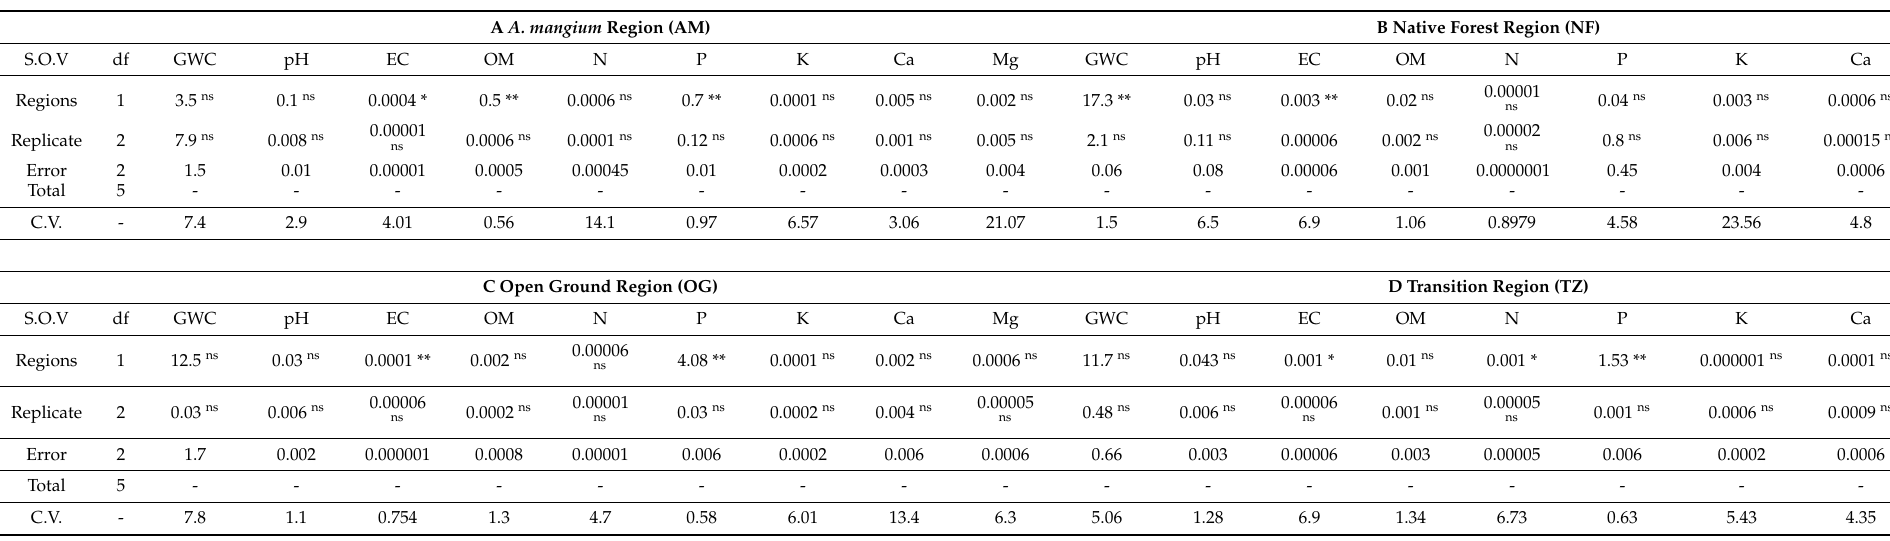
Table 3. ANOVA results of physio-chemical characteristics of top- and sub-soil in the four regions of